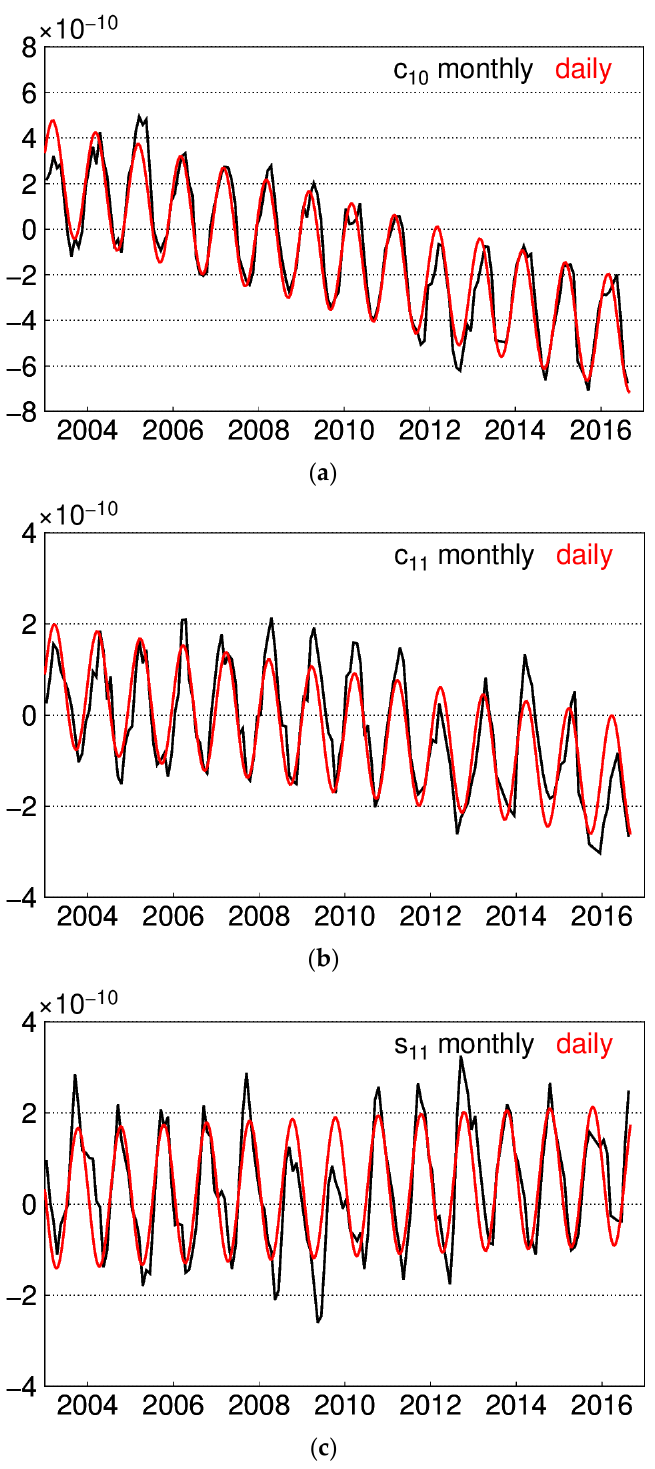
Figure 2. Monthly and daily interpolated degree-1 time series: ( a ) c 10 series; ( b ) s 10 series; ( c ) s 11 series.